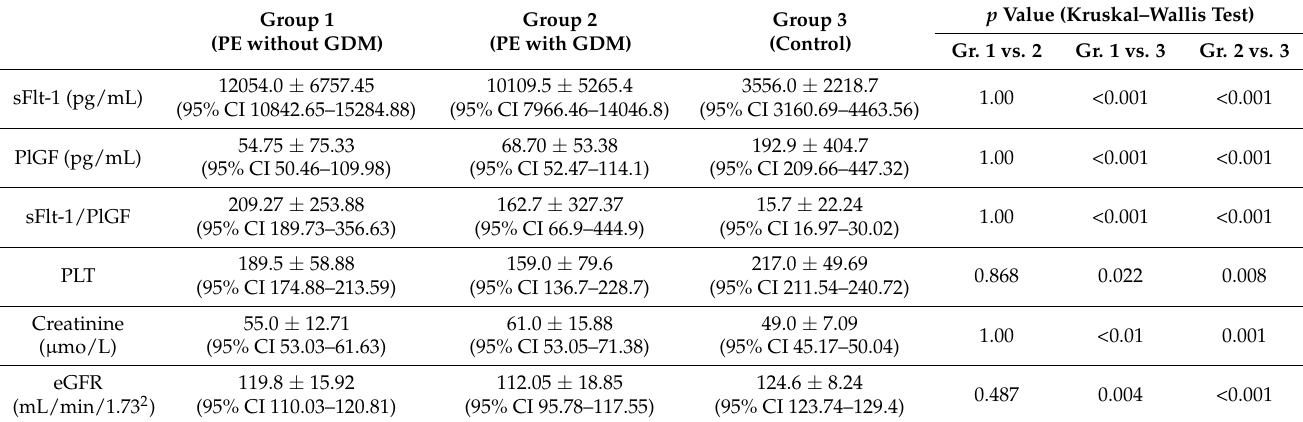
Table 3. Biochemical parameters (median value of each parameter with